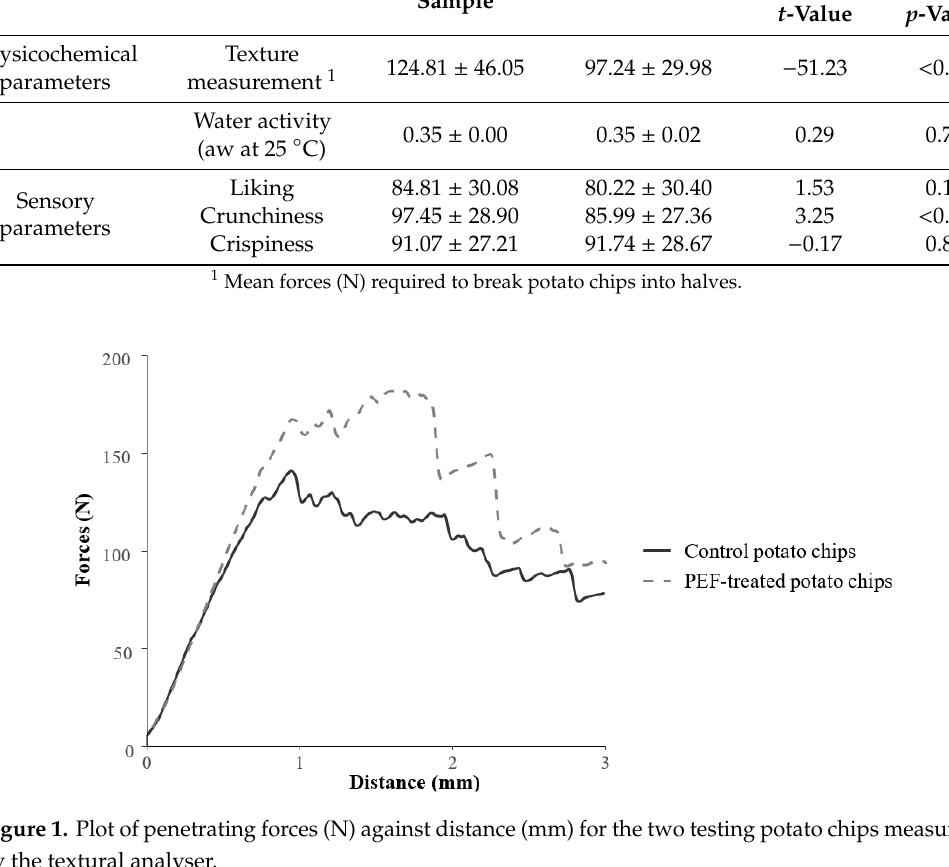
Table 2. Summary of means (and standard deviation) of the physicochemical and sensory parameters of the PEF-treated and control potato chips used in this study.